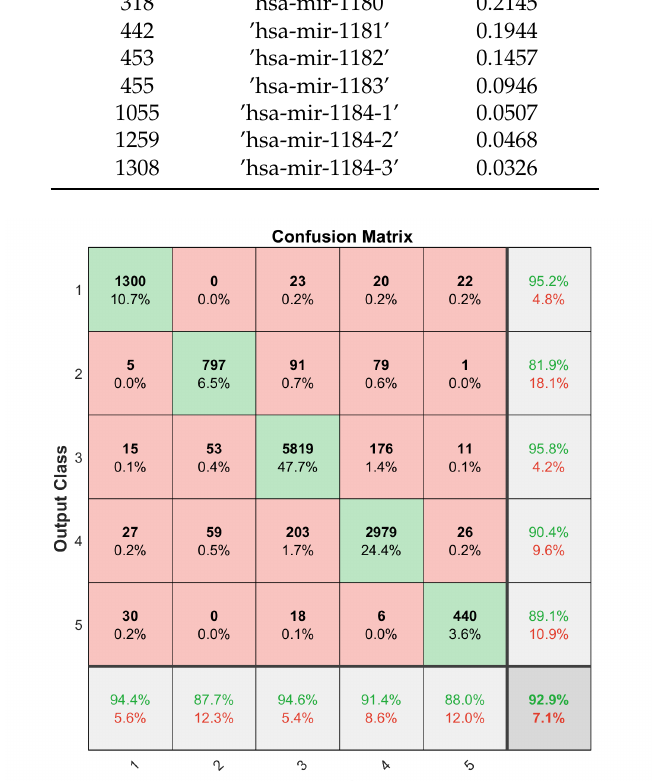
Figure 6. Classification results using all of the 1627 miRNAs as